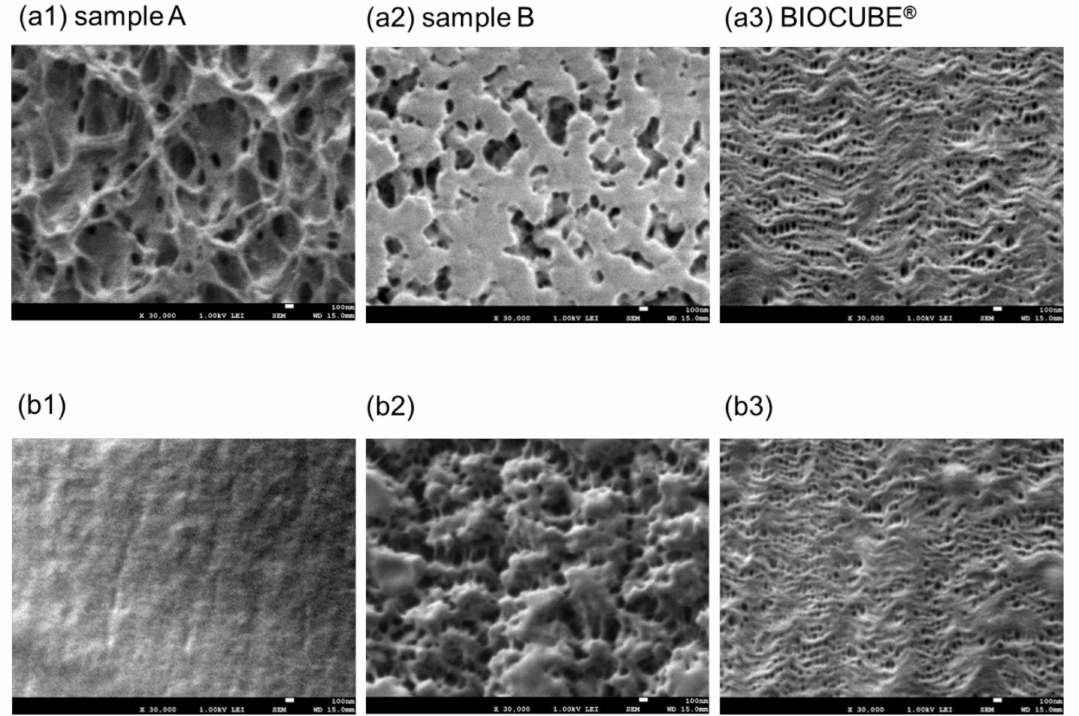
Figure 2. FE-SEM images of Capiox ® LX2 (dry), FX (dry), and NIPRO BIOCUBE ® (dry), ( a ) the surface of the inner lumen of the capillary membranes, ( b ) the outer surface of the capillary membranes, respectively, × 30,000. (1) sample A (Capiox ® LX2), (2) sample B (Capiox ® FX), and (3) BIOCUBE ®